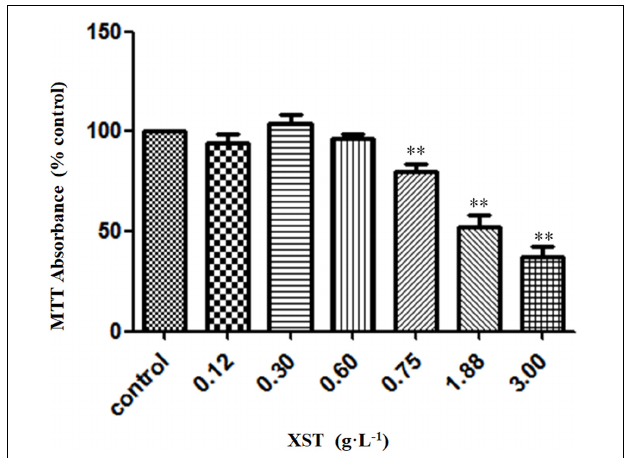
FIGURE 1 | Effects of XST on viability of HUVECs. Cells were treated with 0.9% saline water or XST for 24 h. Cell growth was measured by MTT assay. The data was presented as means ± SD, n = 5. ∗∗ P < 0.01 vs.